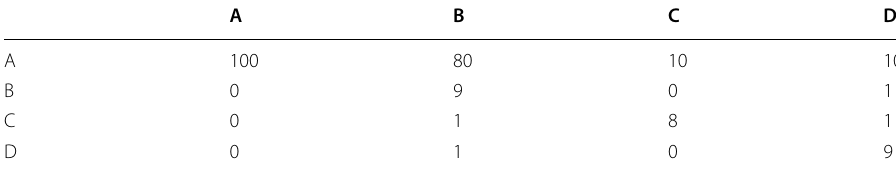
Table 15 Example of confusion matrix for a multiple